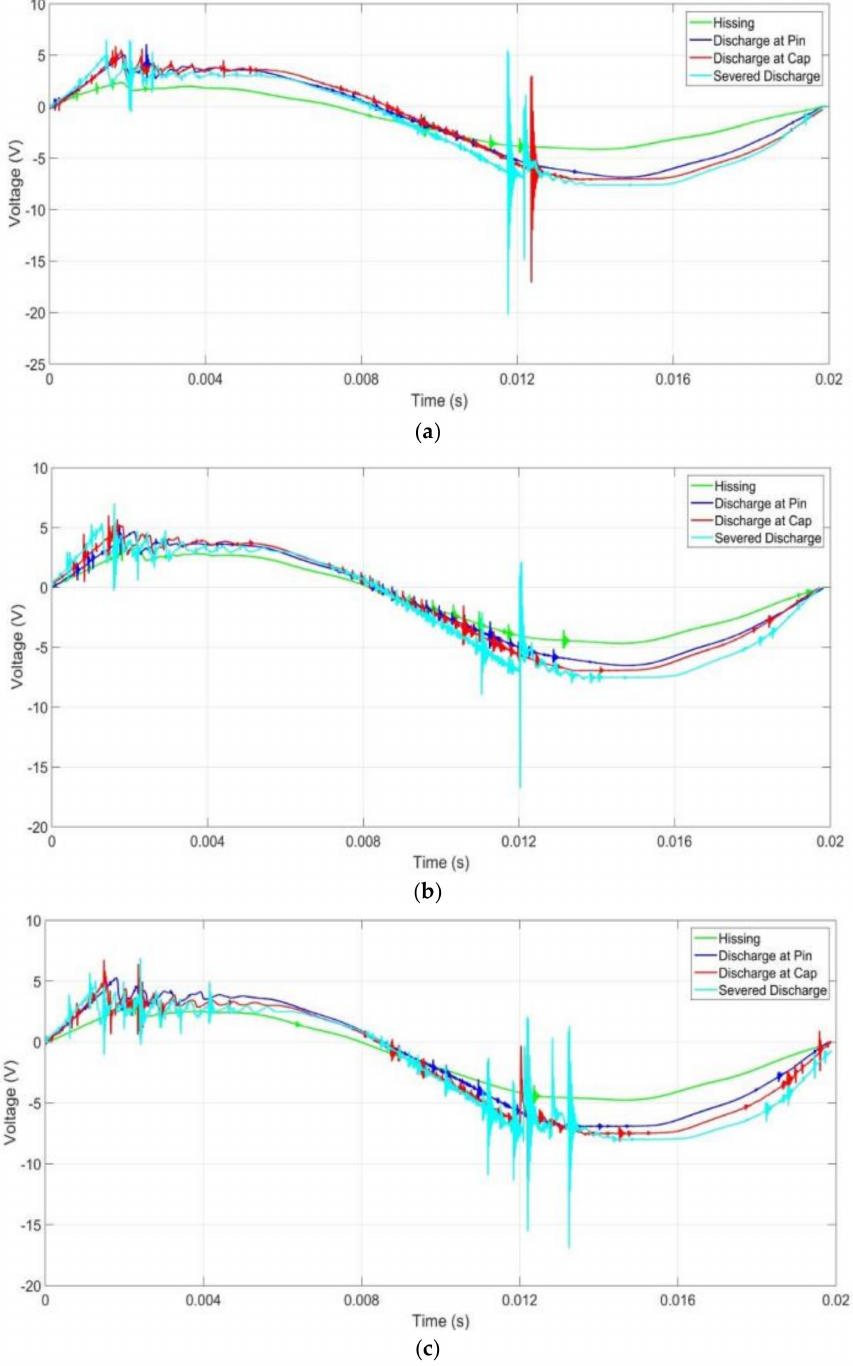
Figure 10. UV signals for insulator samples under dry conditions with light contamination level: ( a ) Group A; ( b ) Group B; ( c ) Group